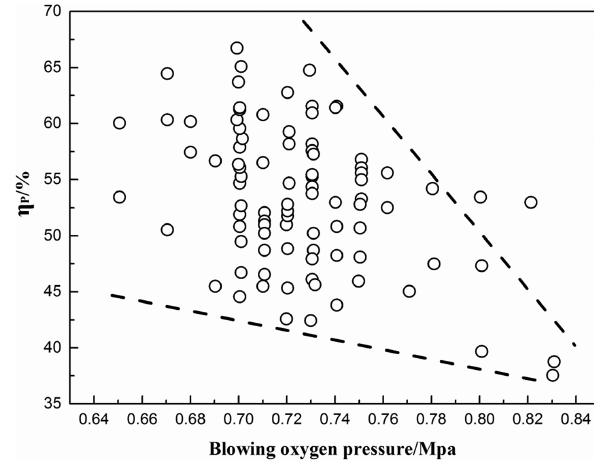
Figure 5: Influence of basicity on dephosphorization ratio.